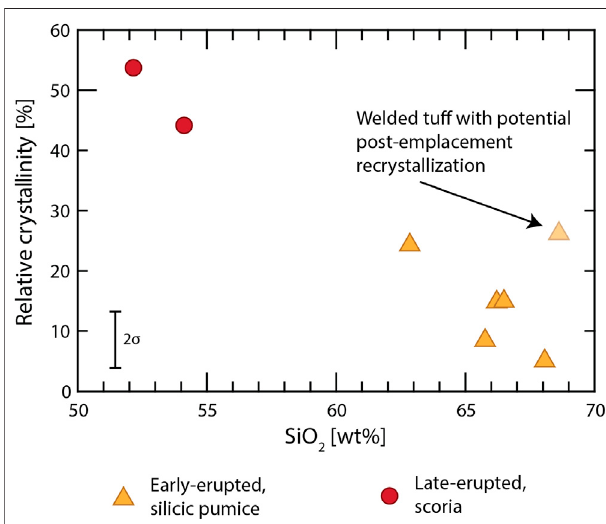
FIGURE 3 | Plot of bulk SiO 2 content vs. crystallinity of early-erupted, silicic pumices and late-erupted scoria. Crystallinity in early-erupted pumices is markedly lower than in late-erupted scoria.